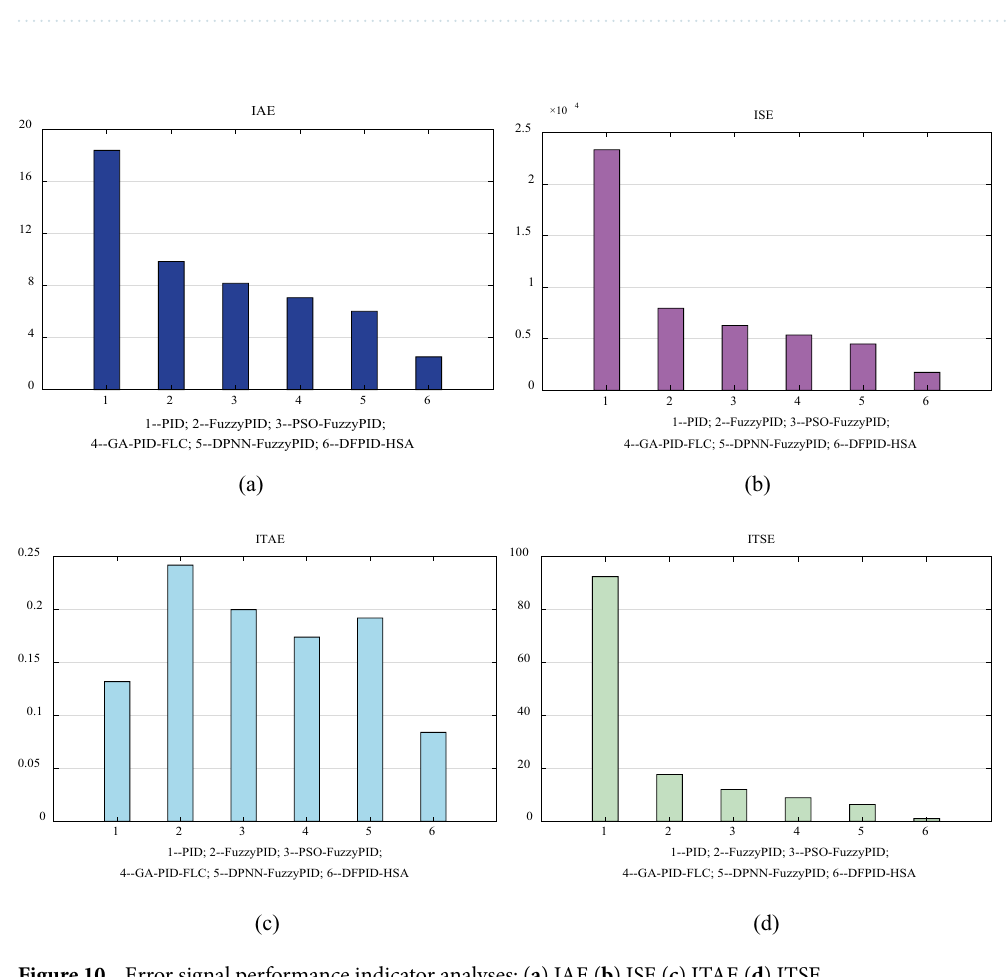
Figure 10. Error signal performance indicator analyses: ( a ) IAE ( b ) ISE ( c ) ITAE ( d )